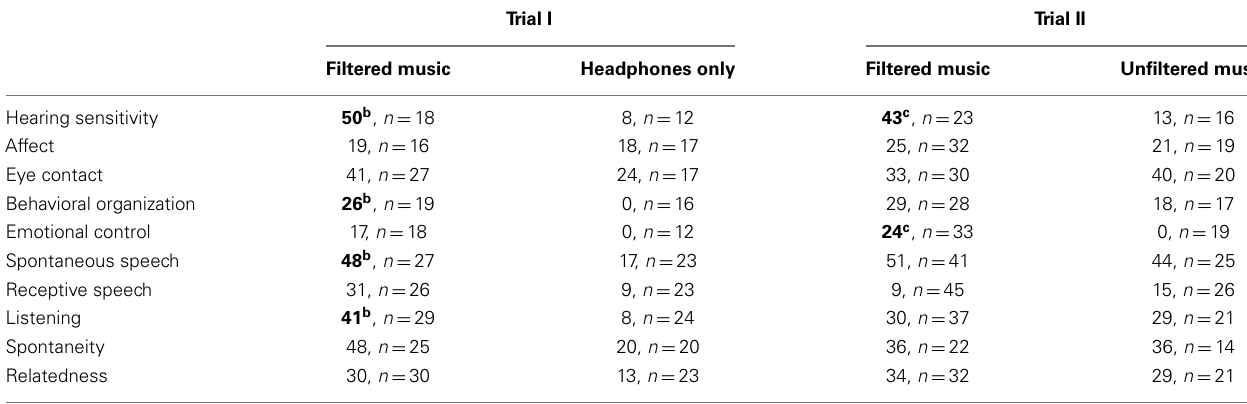
Table 4 | Percent a improving who had a problem within each behavioral domain at the 1-week follow-up